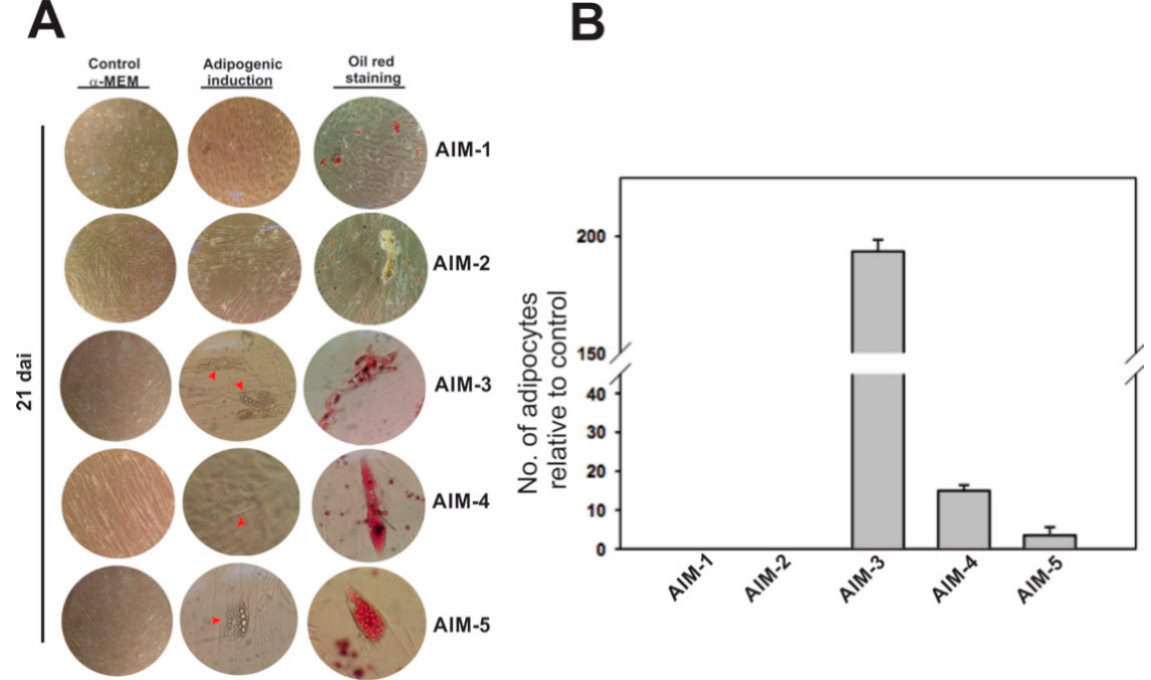
Figure 5. Effects of induction media on the adipogenic capacity of dental pulp stem cells (DPSCs). ( A ) Comparison of different adipogenic induction media (AIM, see Table 1) for induction in DPSCs and Oil Red O staining showing lipid accumulation in adipogenically induced cultures for up to 21 days (21 dai.). Red arrowheads show adipose cells containing lipid droplets. ( B ) Number of adipocytes obtained for each medium shown in A. Values were expressed as means ± SDs of three independent experiments.